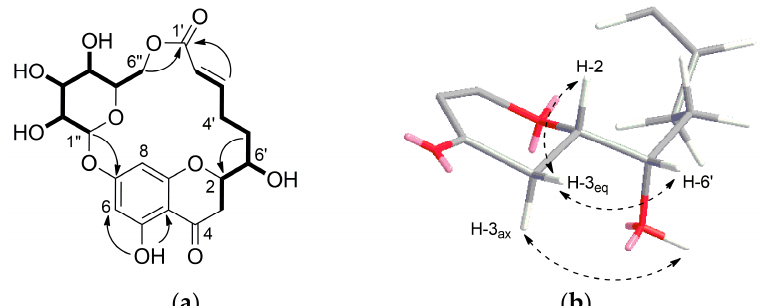
Figure 2. ( a ) 1 H- 1 H COSY ( ― ) and key HMBC ( → ) correlations of moniristenulide ( 1 ); ( b ) ROESY correlation (dashed arrow) establishing relative configuration of 1 . Table 1. 1D and 2D NMR (500 MHz) data of moniristenulide ( 1 ) in DMSO- d 6 ( δ in ppm, J in Hz).